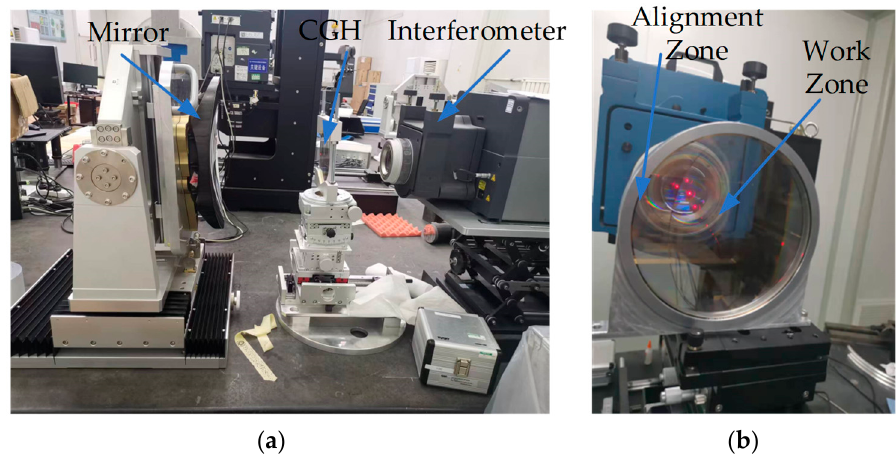
Figure 12. Surface shape test of the mirror: ( a ) light path of test; ( b ) CGH area division.